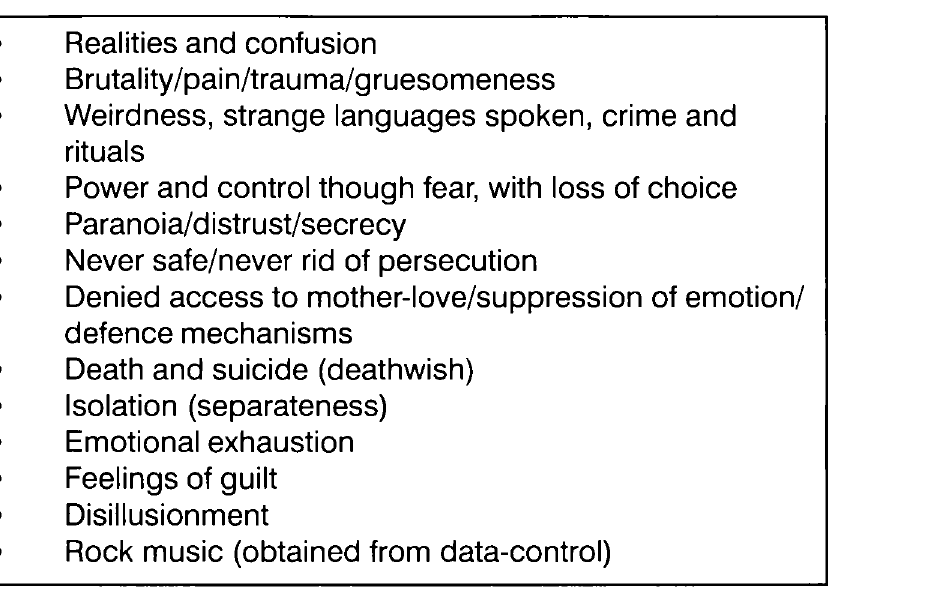
Table 3 : The life-world of adolescents previously involved in